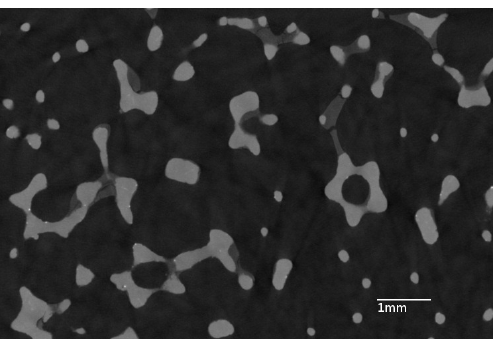
Figure 4. X-ray picture of Alumina layer on aluminum foam-Black: void, dark grey: catalyst, light grey: foam.